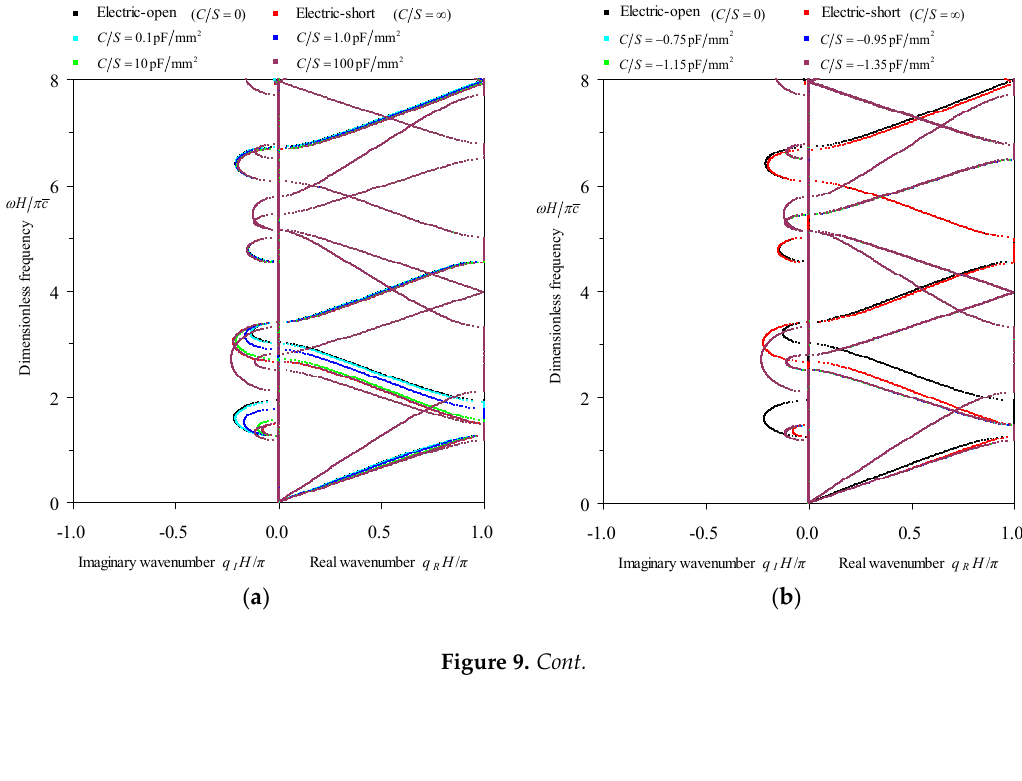
Figure 8. The effect of Brass electrode thickness on the wavenumber spectra of periodic Glass-Brass-(PZT-5H 2 )-Brass multilayers in cases of four electrical boundaries: ( a ) Electric-open condition; ( b )